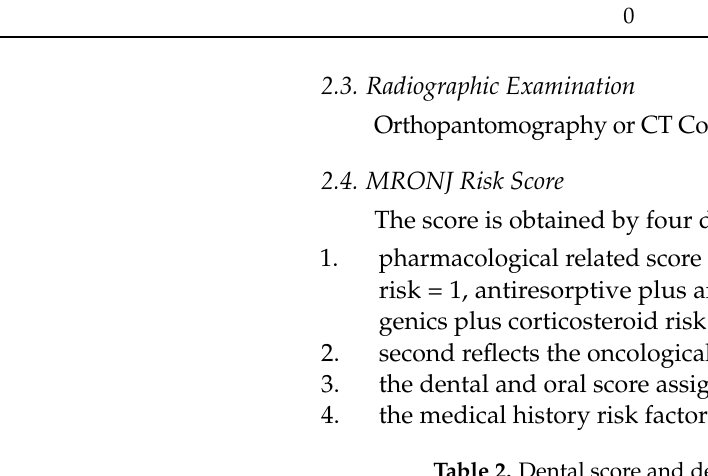
Table 2. Dental score and dental